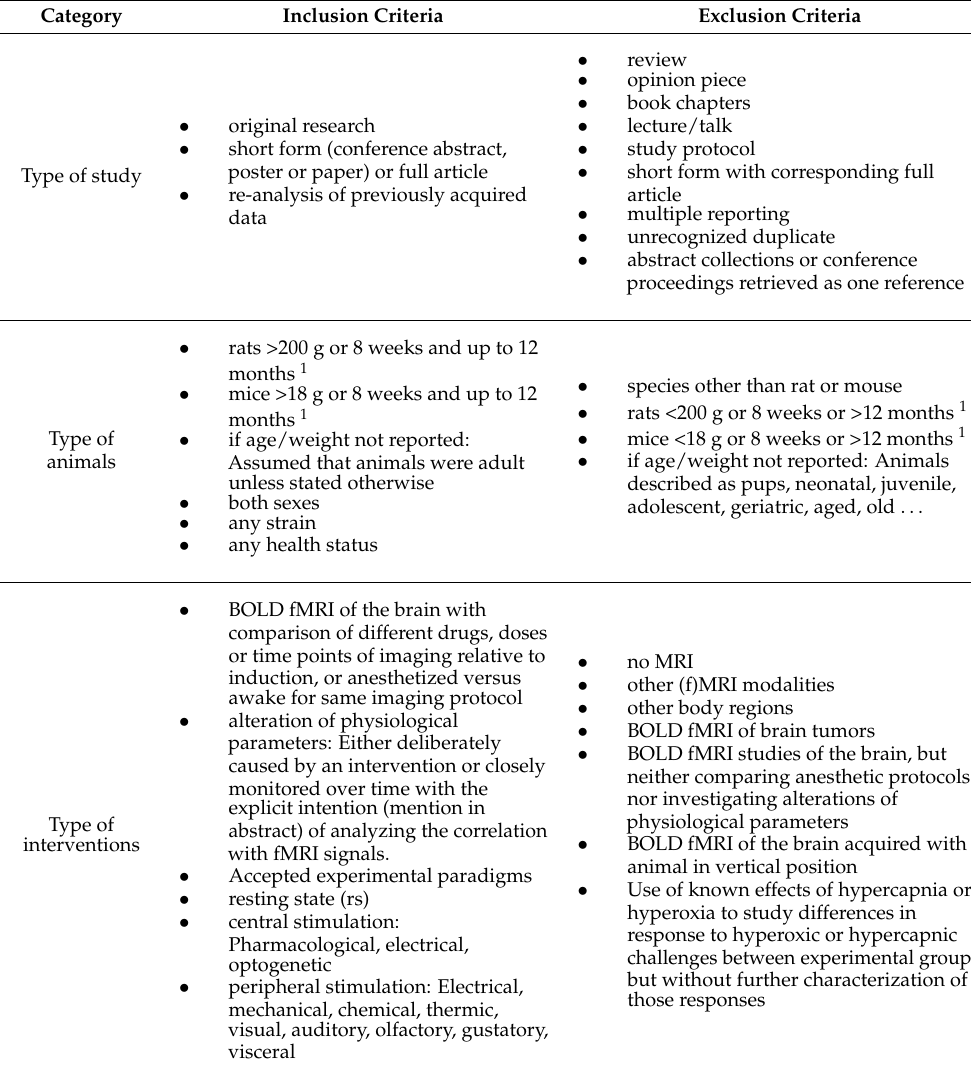
Table 1. Inclusion and exclusion